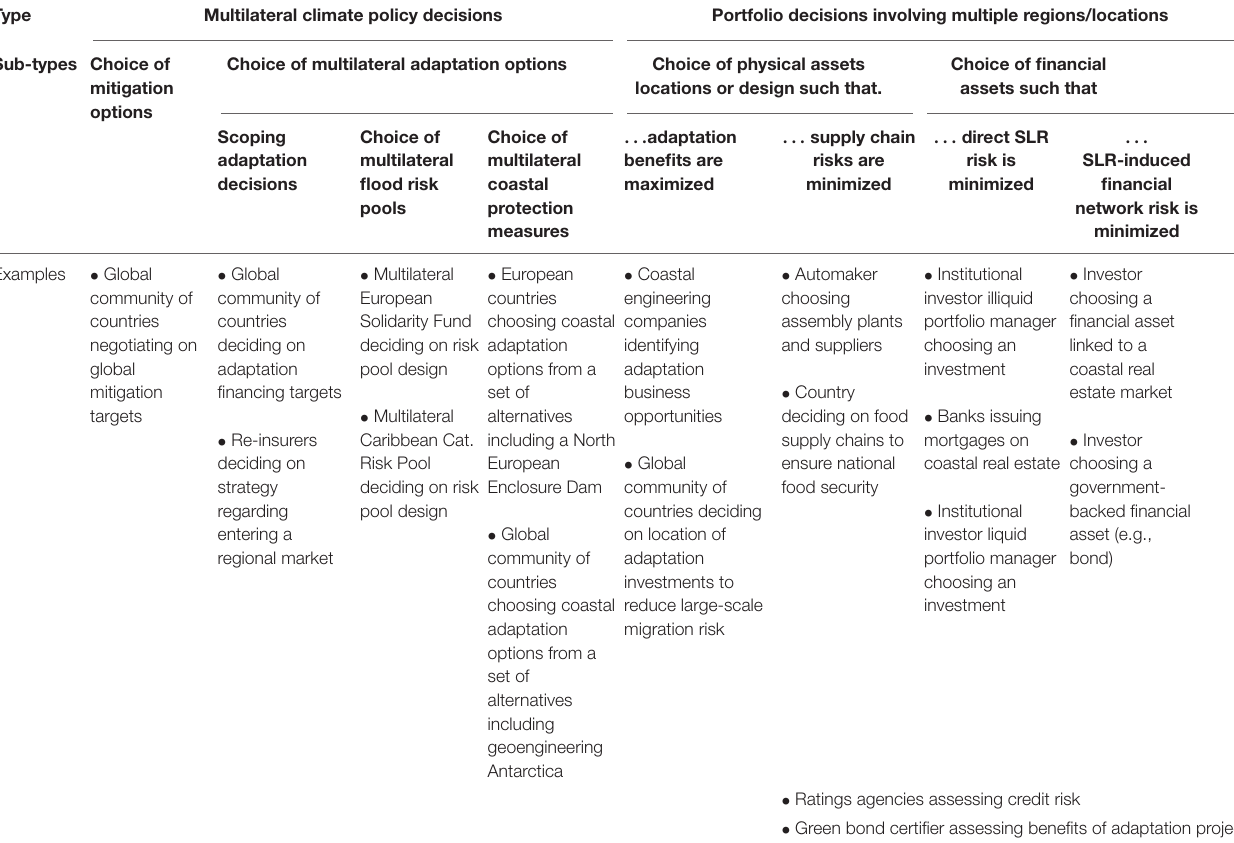
TABLE 2 | A typology of decisions requiring global climate information with examples from the coastal domain.